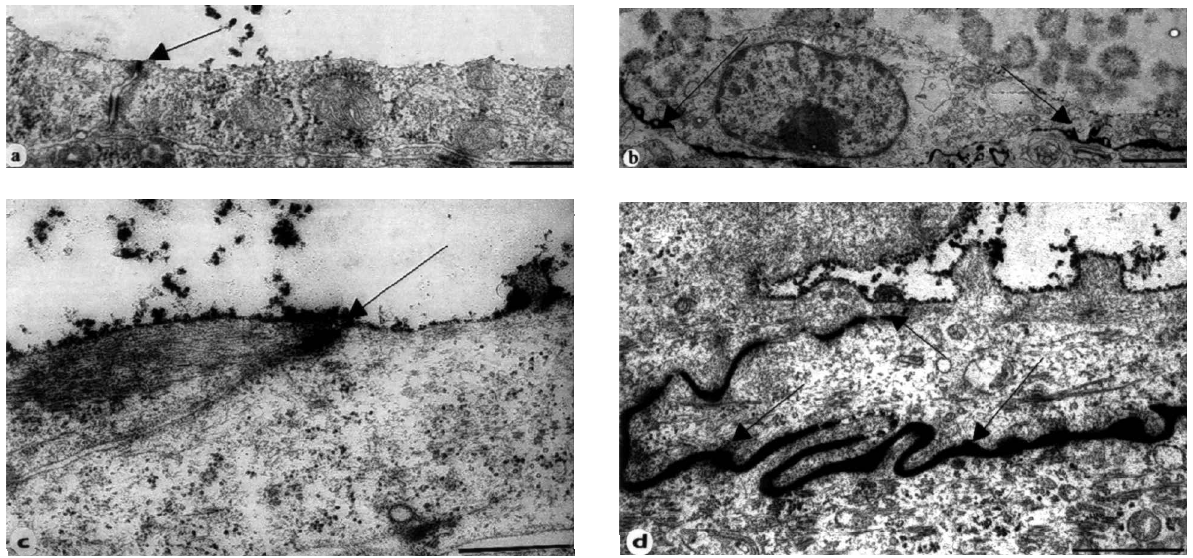
FIG. 4. (a, b) Transmission electron micrographs of 16HBE14o– cells fixed in the presence of lanthanum: (a) control, (b) exposed to 15 m M poly- L -arginine. Bar = 2 m m. (c,d) Transmission electron micrographs of NHBE cells fixed in the presence of